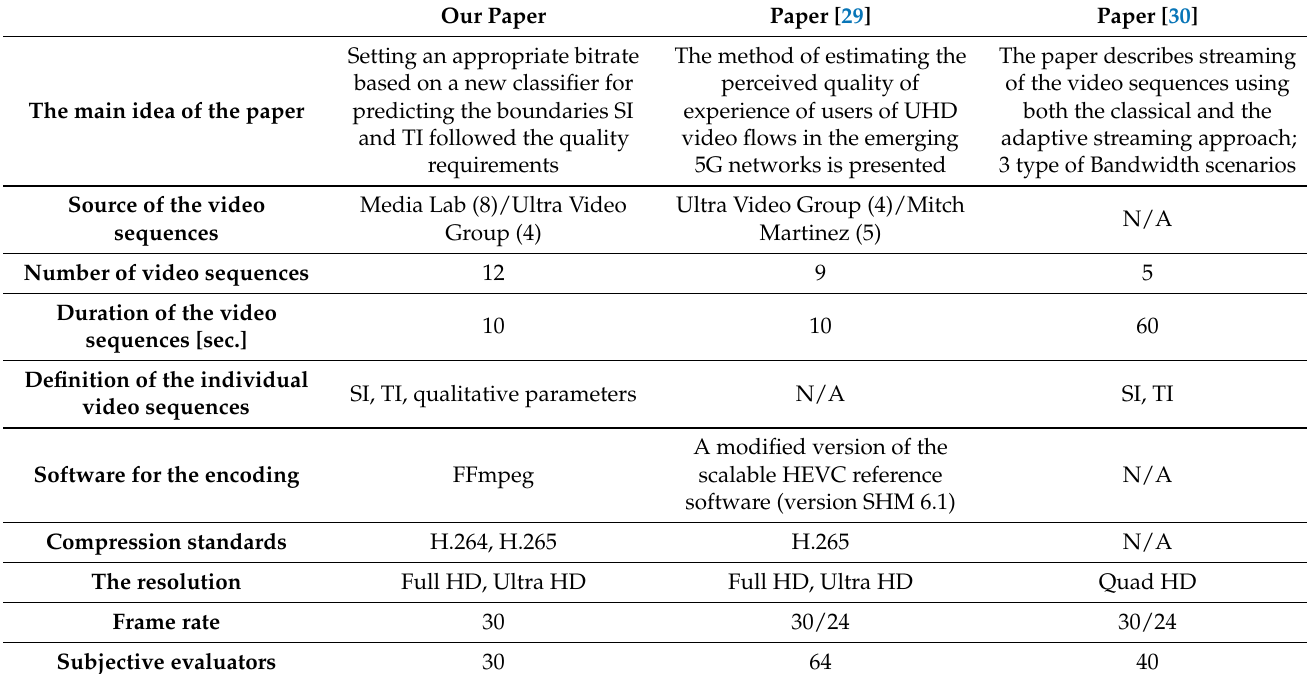
Table 1. A comparison table of the selected relevant